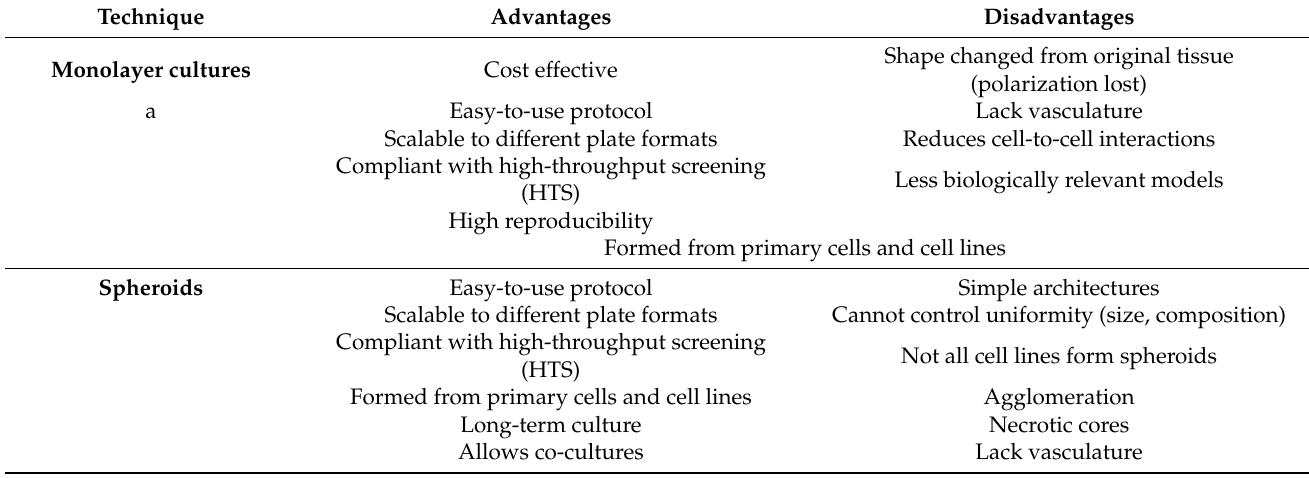
Figure 6. The evolving strategies for culturing and studying PC cells from human tissues. Representative immunofluores- cence images of L3.6pl PDAC cells grown as monolayers ( a ) or spheroids ( b ) (adapted from [34]). ( c ) 3D confocal image of organoids generated by co-culturing PSCs (green) with PANC-1 (red) cells (adapted from [53]). ( d ) Fluorescent image of PANC-1 cells co-cultured with stromal cells on collagen-I scaffold (adapted from [42]). ( e ) Detection of glycosaminoglycans by Alcian blue staining in a homotypic 3D bio-reactor culture of human CAFs generated by bioengineered tumoral microtis- sues (adapted from [62]). ( f ) Representative immunofluorescence image of 3D bioprinted tissues for PDAC (green), PSC (red), and endothelial (yellow) cells (adapted from [68]). ( g ) IF image of the invasion of a heterogeneous co-culture of PDAC cells (adapted from [75]). Table 1. Advantages and disadvantages of in vitro 3D culture